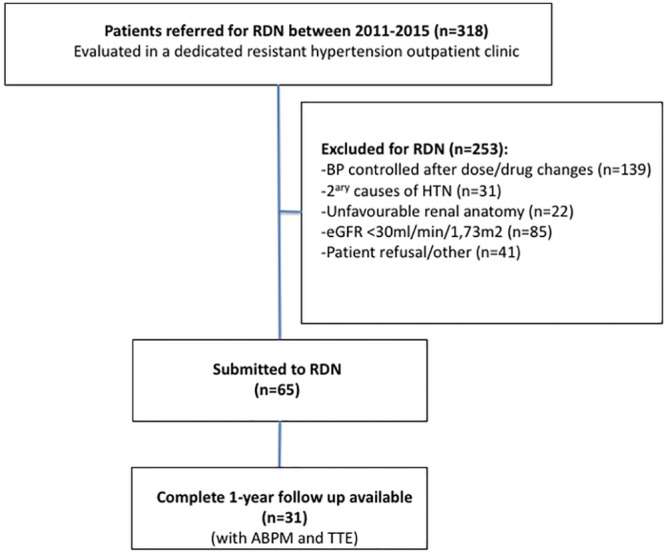
Flowchart with patient selection.From the total number of patients evaluated in a dedicated outpatient hypertension clinic (n = 318), 65 patients were submitted to renal denervation, after the exclusion of 253 due to several reasons listed. From these 65 patients, it was possible to obtain complete 1 year follow up with ambulatory blood pressure measurement and transthoracic echocardiogram. RDN—renal denervation; HTN—hypertension; eGFR—estimated glomerular filtration rate; ABPM –24 hours ambulatory blood pressure measurement; TTE-transthoracic echocardiogram.